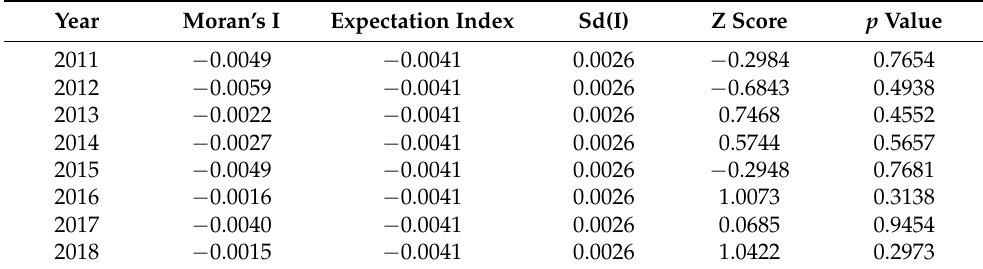
Table 3. Moran’s I of the GTFP